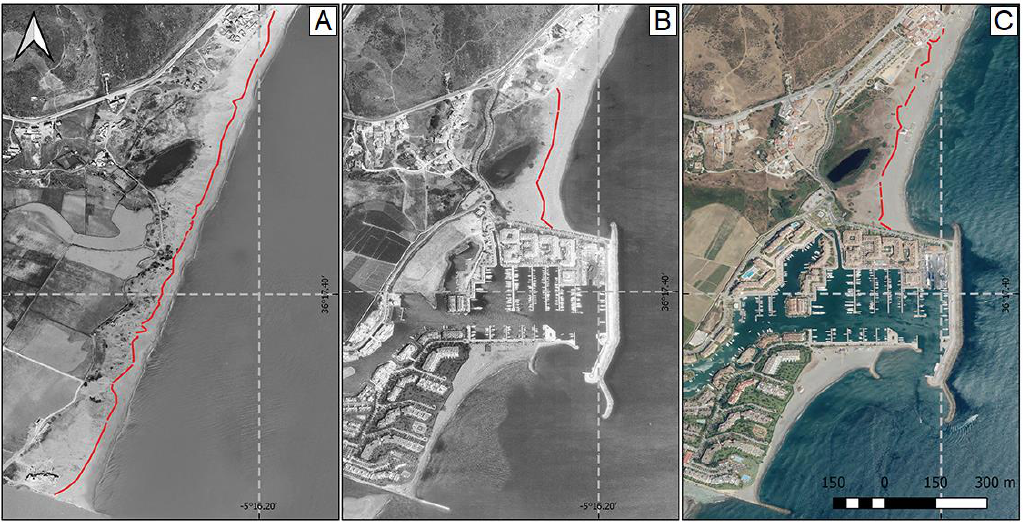
Figure 11. System no. 10 Torreguadiaro (in Cádiz province) recorded a slight decrease of fragmentation in the 1977 – 2001 period and an increase in the 2001 – 2016 period due to the reduction of a high fragmented dune sector that was replaced by the port structure. The dune system located in front of the natural protected Torreguadiaro Lagoon was not modified. In the 2001 – 2016 period, the growth of new dunes at the northern part of the system and the increase of pathways at both sides of it was observed. This resulted in a decrease of fragmentation that changed from ( A ) Class 1 (F = 0.08) in 1977 to ( B ) Class 2 (F = 0.03) in 2001 and an increase of fragmentation to ( C ) Class 3 (F = 0.20) in 2016. Red line represents dune toe position.